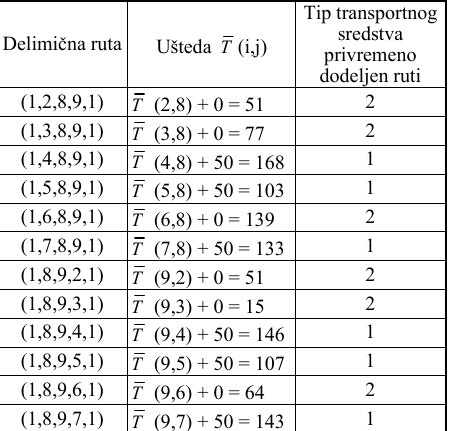
Tabela 5 Tip transportnog sredstva privremeno dodeljen